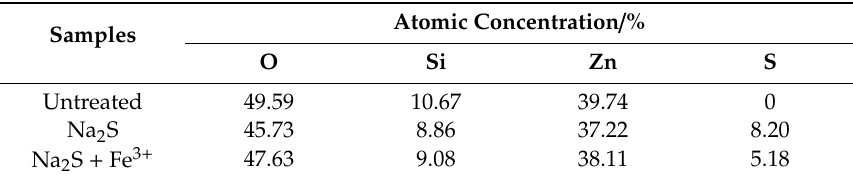
Figure 8. S2p XPS spectra of hemimorphite treated with ( a ) deionized water, ( b ) 5 mM Na 2 S, ( c ) 5 mM Na 2 S + 1mM Fe 3 + . Table 1. Concentrations of various elements on the hemimorphite surfaces. Atomic Concentration/% Samples